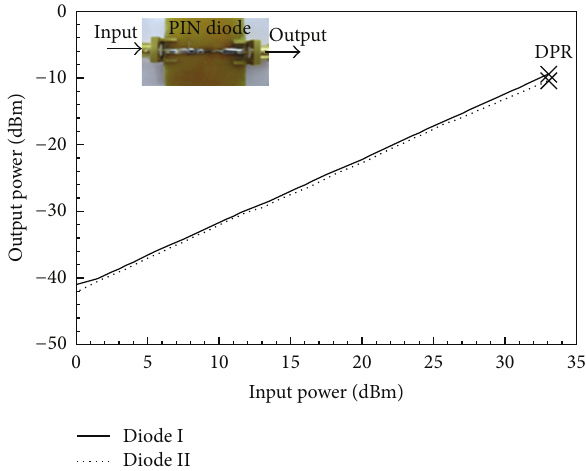
Figure 18: Comparison of the linearity of the PIN diodes (Diode I, Diode